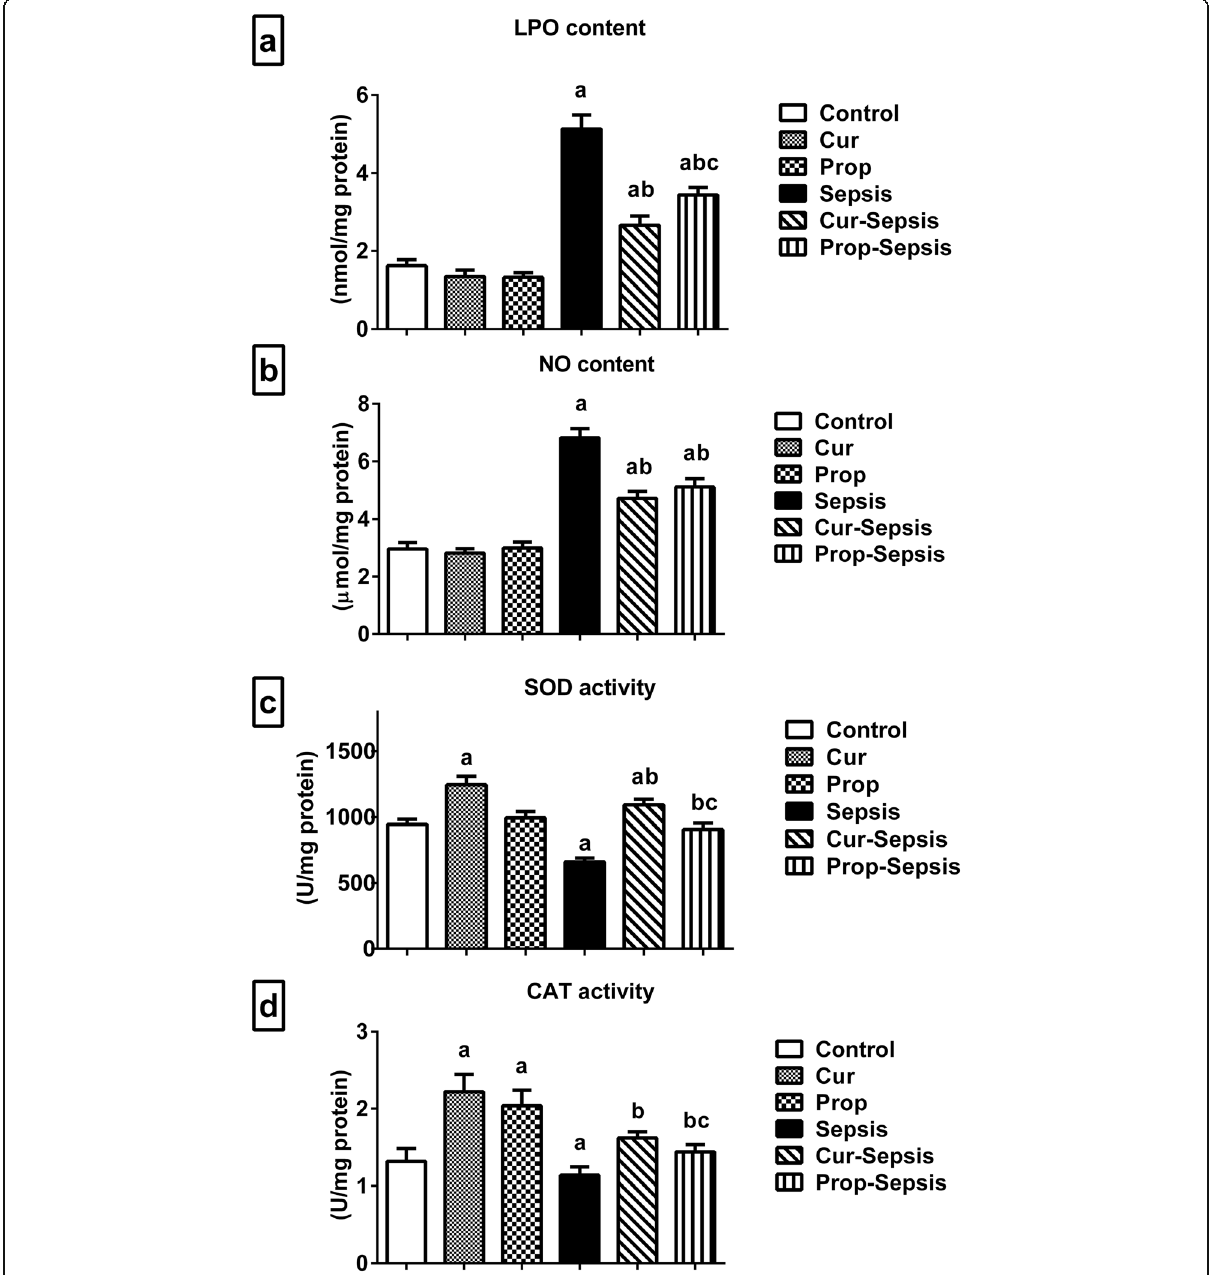
Fig. 2 The effect of either propolis (Prop) or curcumin (Cur) on a lipid peroxidation (LPO), b nitric oxide (NO), c superoxide dismutase (SOD), and d catalase (CAT) in kidney tissue homogenate after sepsis-induction in adult male rats. Data are expressed as mean ± S.E.M for 6 rats/group. a significant difference from control group by one-way ANOVA at P < 0.05; b significant difference from SEP group by one-way ANOVA at P < 0.05; c, significant difference between cur and prop-sepsis and cur-sepsis groups by one-way ANOVA at P <